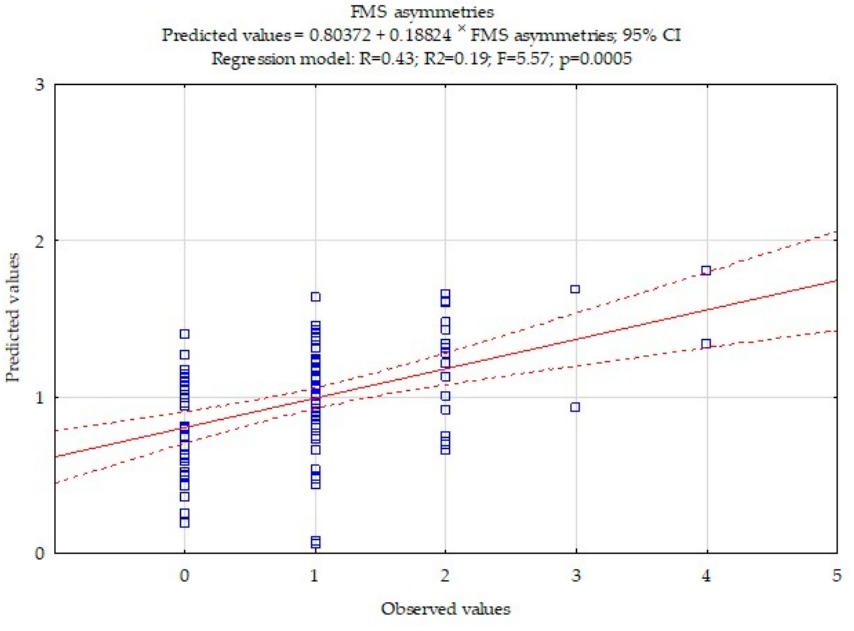
Figure 2. Multiple regression model for FMS asymmetries number. Multiple regression results for FMS asymmetries numbers are included in Table 4. Flexibility had the strongest statistically significant impact on FMS asymmetries ß = − 0.30, p = 0.0014. Additionally, FMS asymmetries depend on abdominal muscles strength ß = − 0.29, p = 0.0027. An increase in the sit-and-reach test score by 1 cm is associated with reducing asymmetries by 0.04. An increase in the sit-ups test by one rep reduces FMS asymmetries number by 0.05. Table 4. Multiple regression results for FMS asymmetries number. Dependent Variable